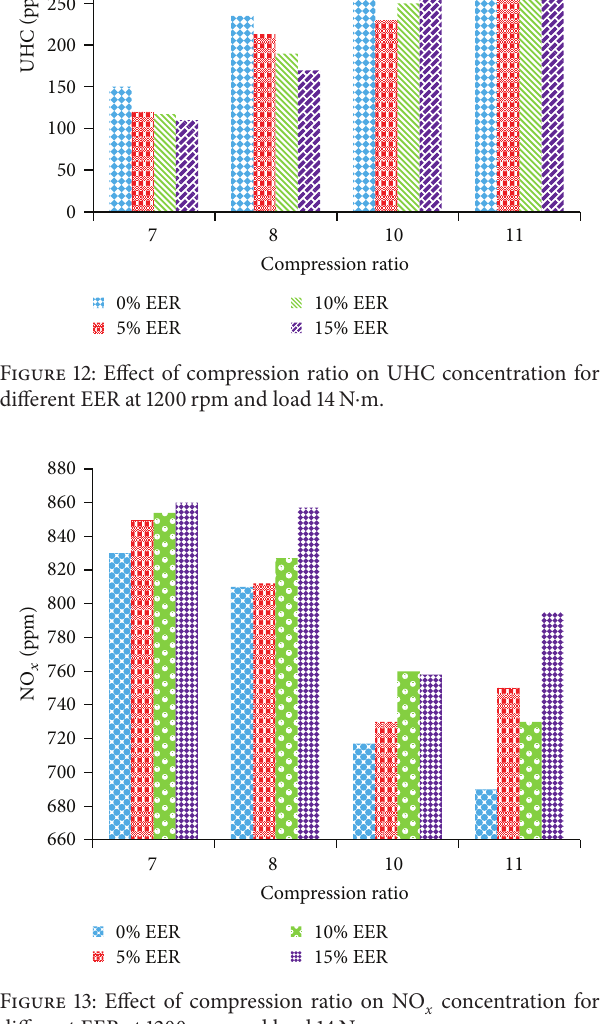
Figure 11: Effect of compression ratio on CO concentration for different EER at 1200rpm and load 14N ⋅ m.